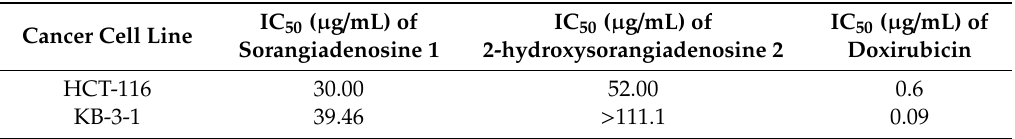
Table 2. Half-maximal inhibitory concentrations (IC 50 values in µ g / mL) of sorangiadenosine, 2-hydroxysorangiadenosine ( 1 and 2 ) and doxorubicin (used as cytotoxic positive control) against HCT-116 (human colon carcinoma cell line, DSMZ No. ACC 581) and KB-3-1 (cervix carcinoma cell line, DSMZ No. ACC